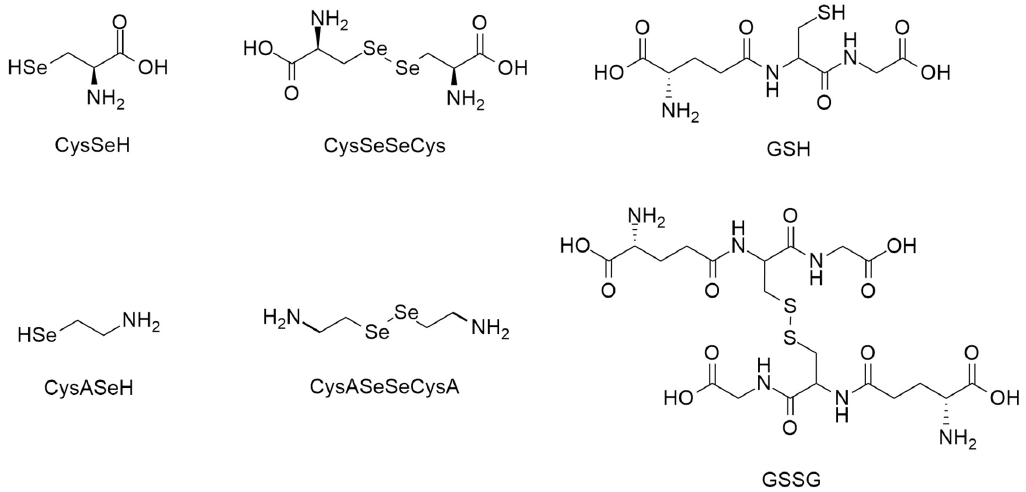
Figure 4. Constitutional formulae of selenocystine (CysSeH), selenocystine (CysSeSeCys), glutathione (GSH), oxidized glutathione (GSSG), selenocysteamine (CysASeH), and selenocystamine (CysASeSeCysA).